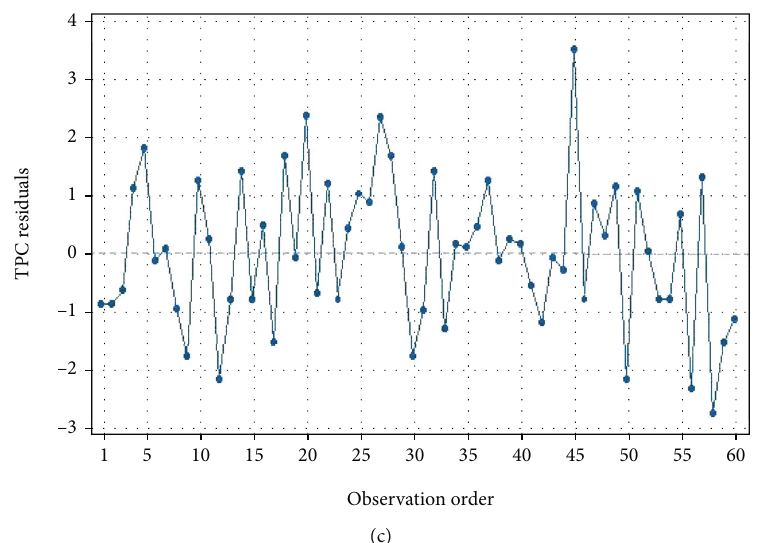
Figure 1: (a) Normal Probability vs residuals, (b) residuals vs fi tted value, and (c) residuals vs. observation order for